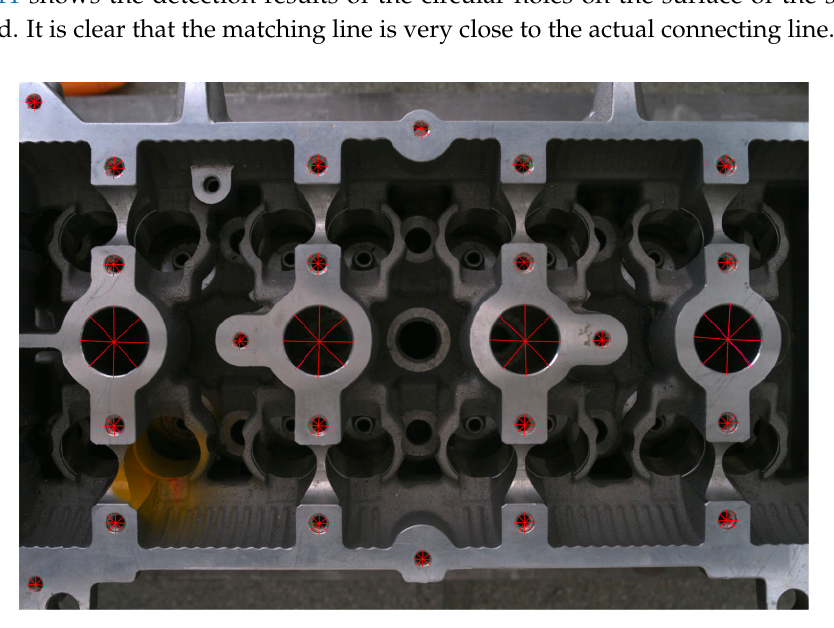
Figure 12. Average pixel errors of the radii of detected circles on the surface of engine cylinder head. 4. Discussion According to the algorithm proposed in this paper, the dimension of the cylinder head circular hole can be accurately detected, which means this method is suitable for this specific problem. However, detecting the faults of other cylinder parts still needs further research. Moreover, the models accumulated in the experiment are not sufficient. Thus, there is still some room for development in the engineering practice. 5. Conclusions In this paper, a detection algorithm based on feature point matching is proposed. First, the feature vectors are obtained based on the improved sparse Haar-like feature. Then, the feature similarity is calculated by Euclidean distance and activation number to obtain the most similar matching point in the region. However, Haar features are easily affected by illumination conditions. In order to improve the robustness of detection, from the point of view of algorithm theory, a method